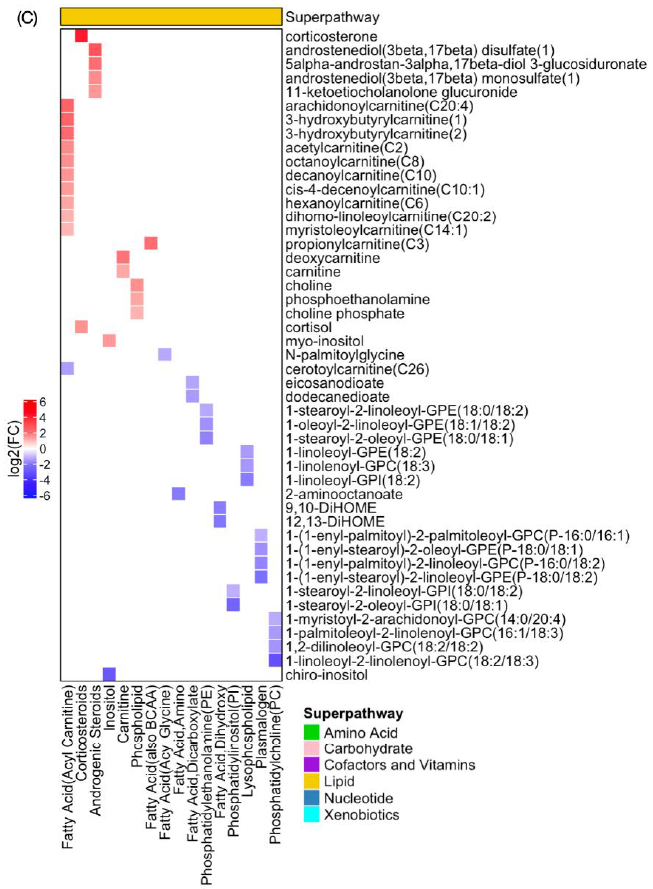
Figure 3. Heatmaps showing significantly dysregulated metabolites between 0 Gy and 12.5 Gy exposure at TP2 at the subpathway level for ( A ) amino acids, ( B ) carbohydrate, cofactors and vitamins, nucleotide, xenobiotics, and ( C ) lipid superpathway. The x -axis represents subpathways.